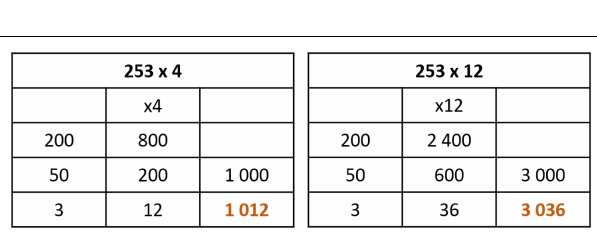
FIGURE 10 | Multiplication algorithms (one digit and two digits) in Open method Based on Numbers